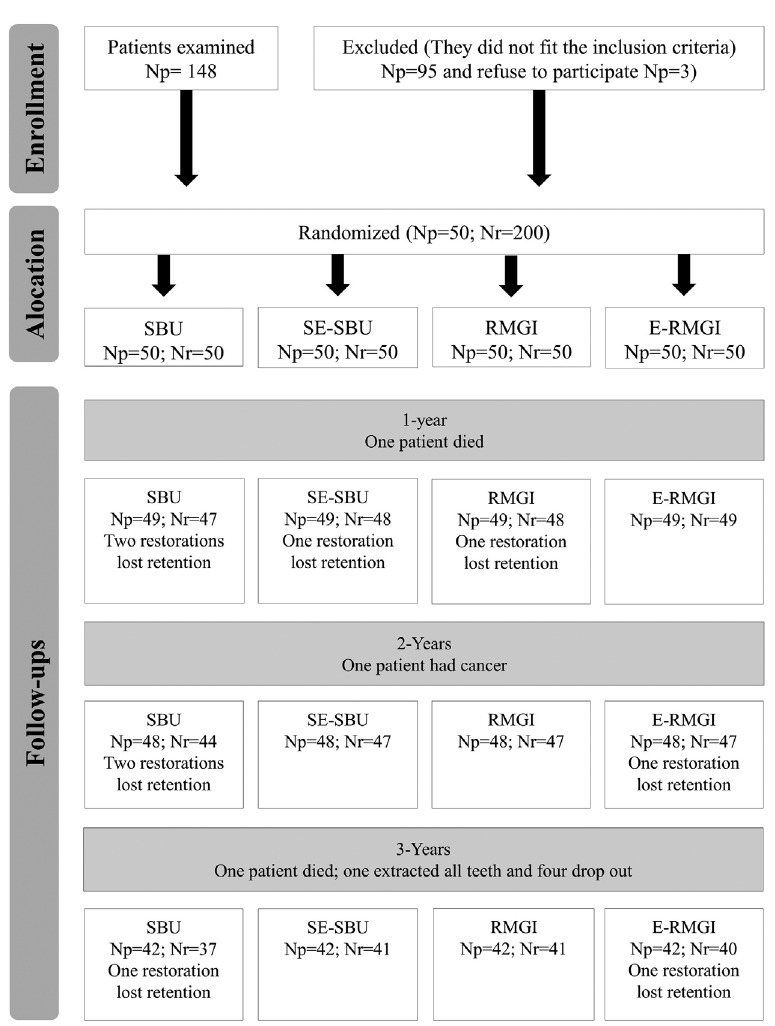
Figure 1- Patient flowchart. Np: patient number, Nr: restoration